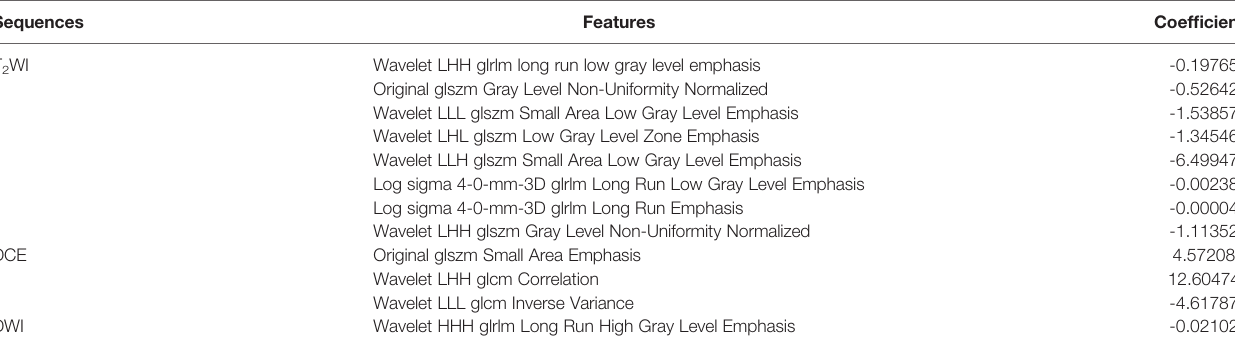
TABLE 2 | Results of the feature selection for the model based on DCE, DWI and T 2 WI.